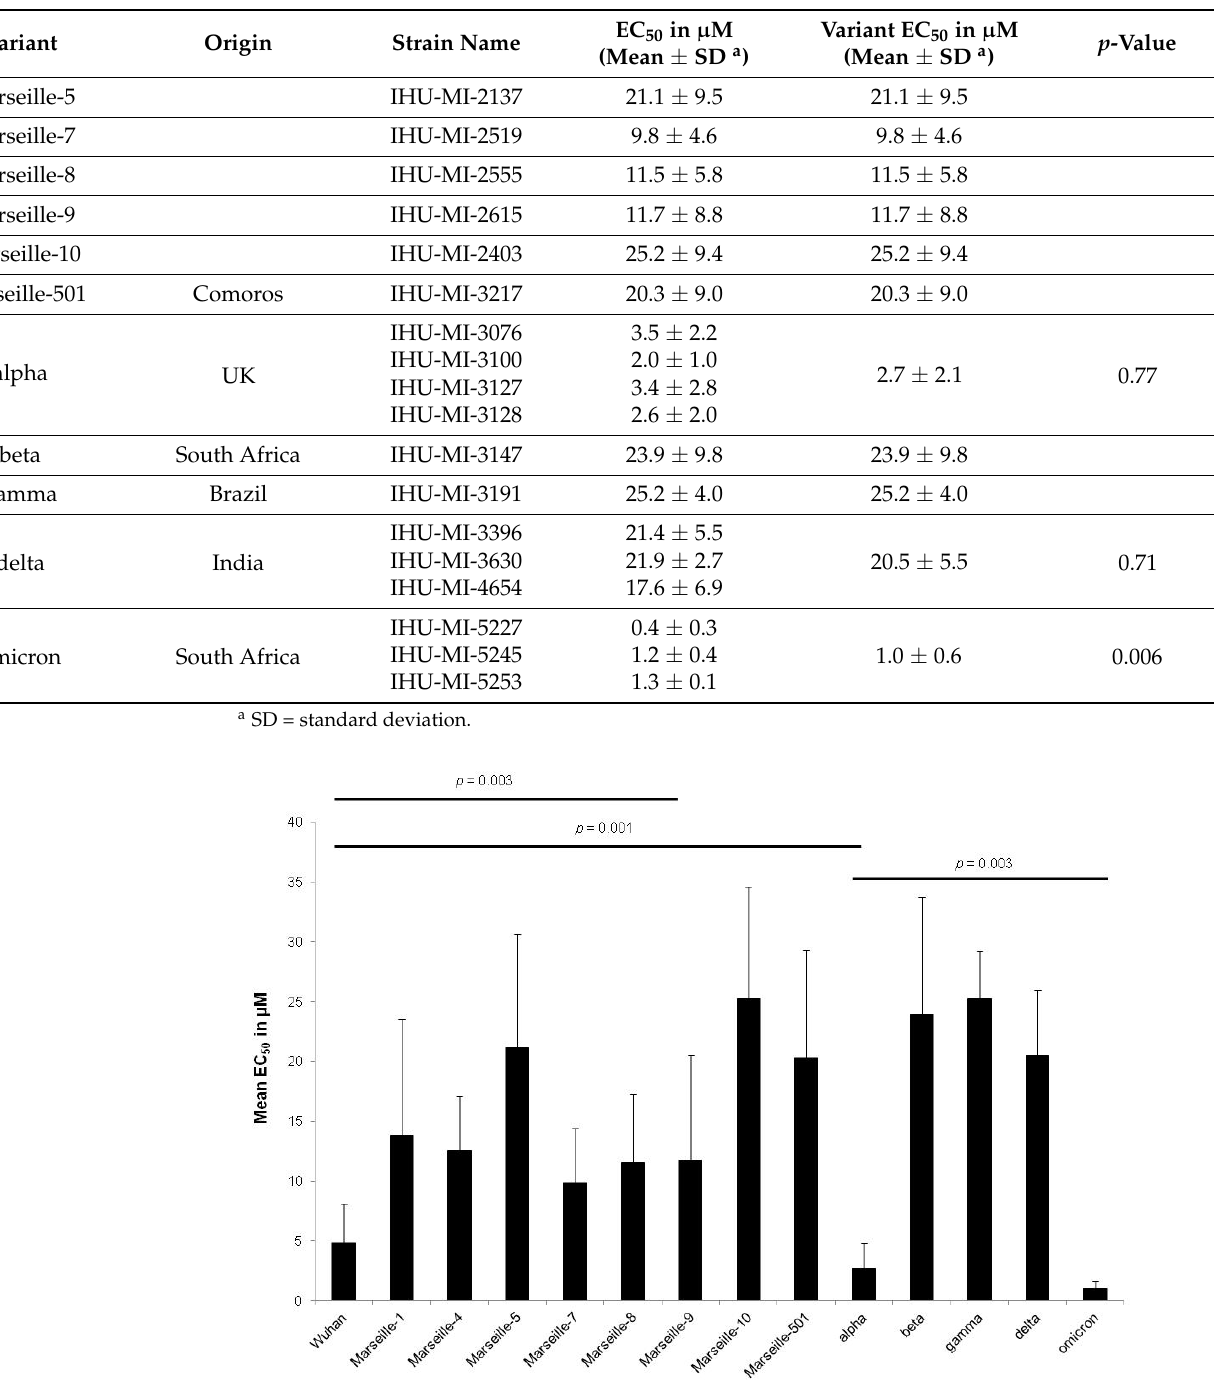
Figure 3. EC 50 means of remdesivir according to the 14 clinically isolated variants of SARS-CoV-2 (error bar represents the standard deviation of 5 to 11 independent experiments).